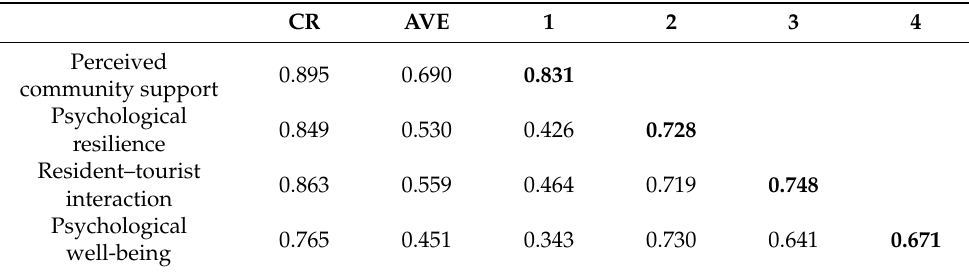
Table 4. Testing discriminant